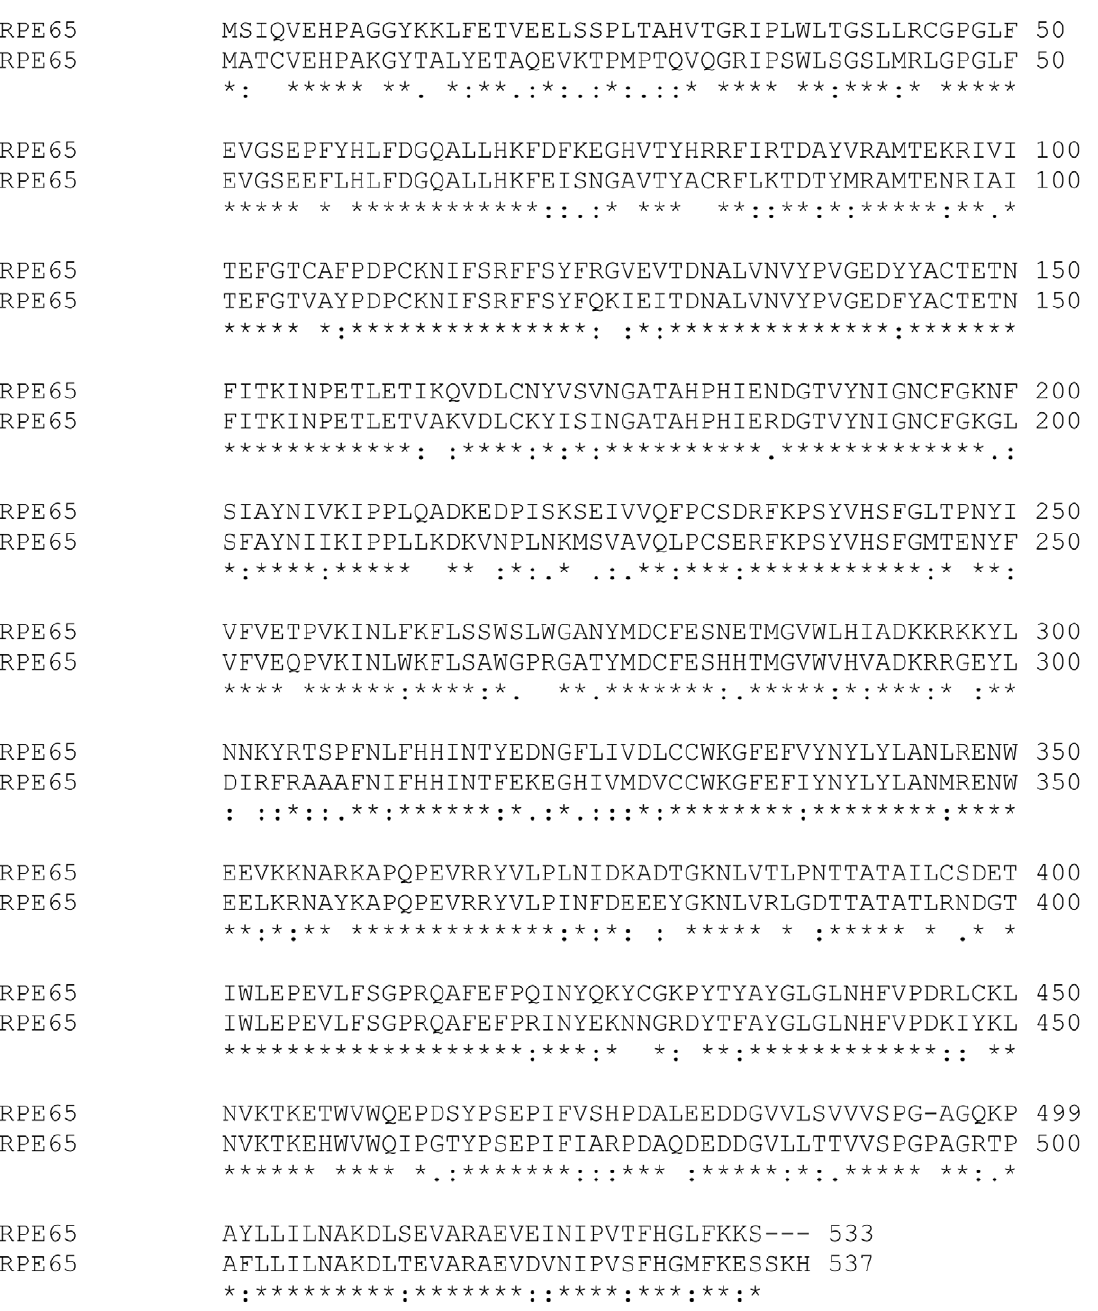
Figure 5. Alignment of Human and Lamprey RPE65. CLUSTAL W (1.83) alignment of Human RPE65 and Lamprey RPE65. GenBank/EBI accession numbers are as follows: human RPE65, NP_000320, lamprey RPE65 JX115001. Red , conserved residues around catalytic